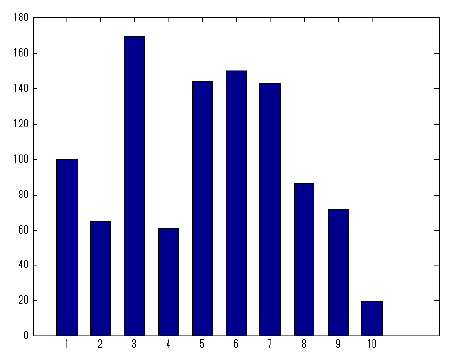
Figure 18. Classification with NRCS values in each cluster